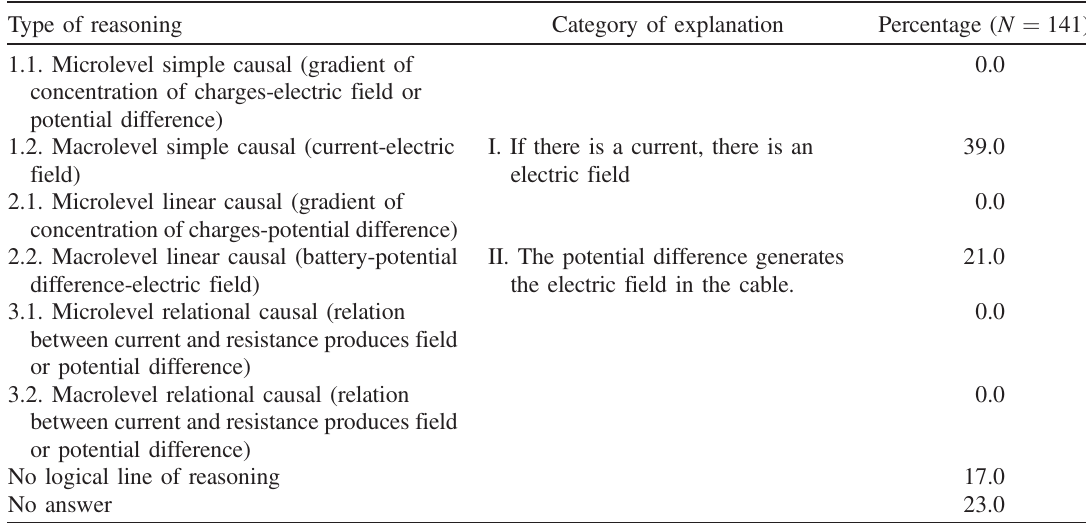
TABLE I. Types of reasoning and explanations in question Q1, which asks about the concept of electric field in electrostatics and dc circuit